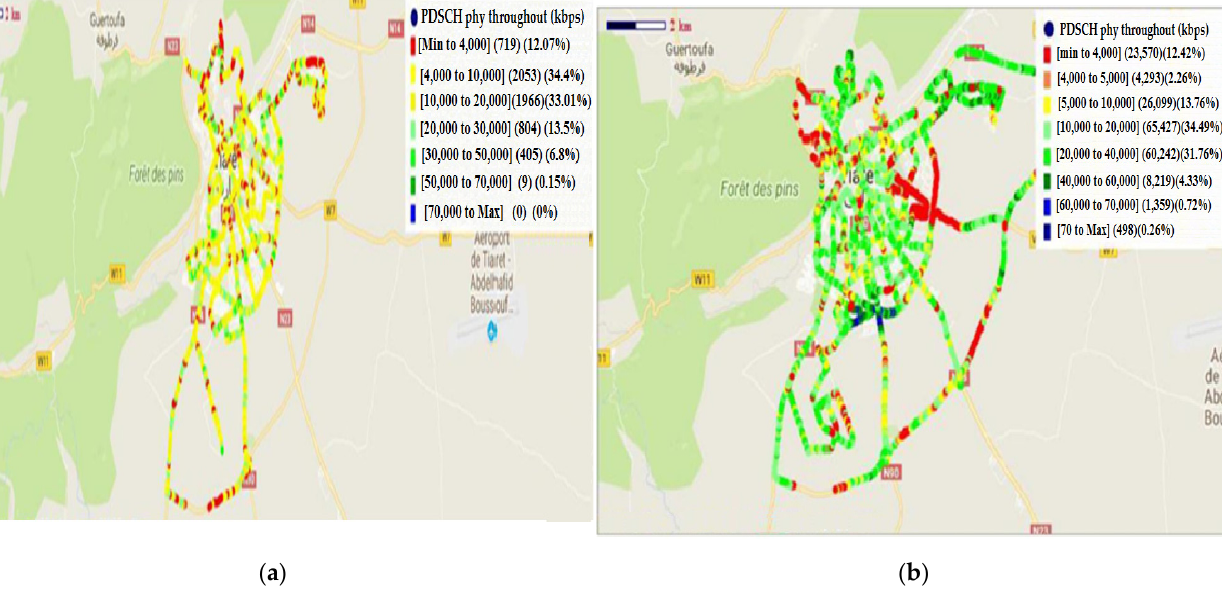
Figure 13. PDSCH physical throughout: ( a ) before treatment; ( b ) after treatment.